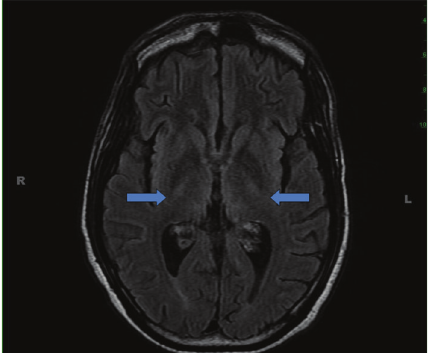
Figure 3: MRI demonstrating slight increase in T2 signal in the medial bilateral thalamus